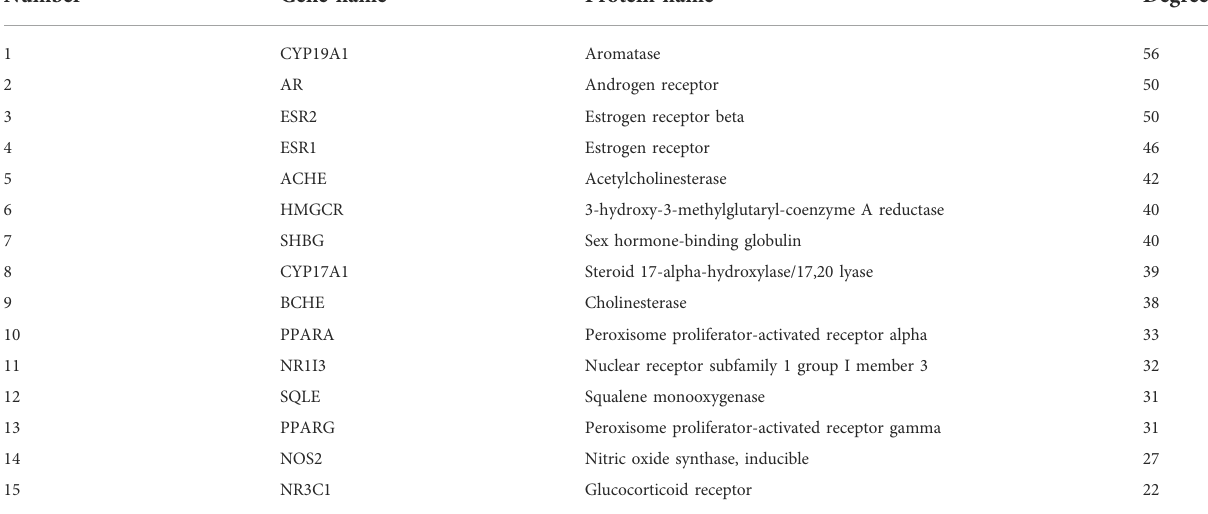
TABLE 5 The top 15 CCMM-MI common targets with high degree